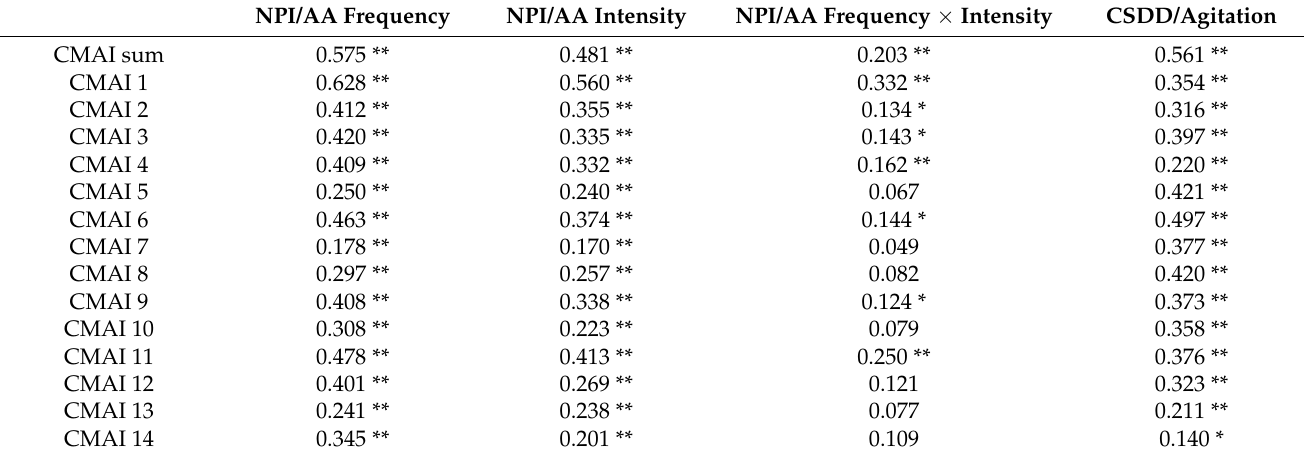
Table 5. Concurrent correlation of the CMAI with the NPI/AA and